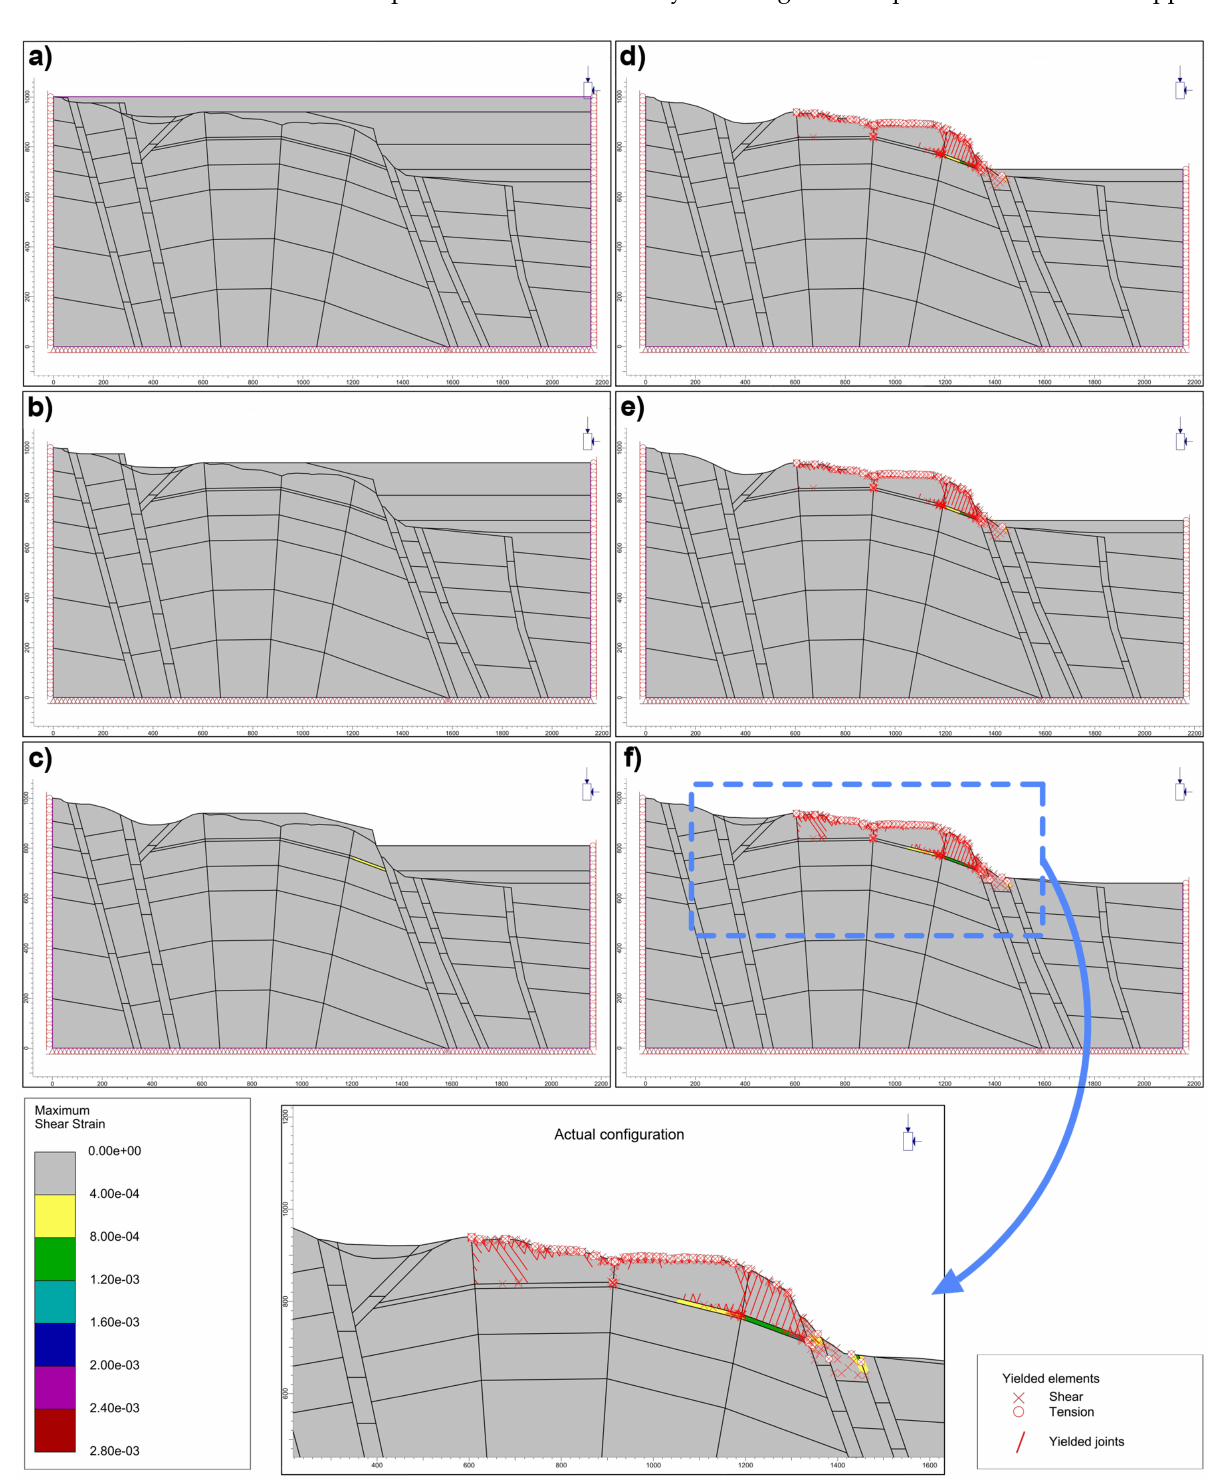
Figure 13. Evolutionary model, maximum shear strain, and yielded nodes/joints along the modeled section: ( a ) Initial condition; ( b ) Early-Middle Pleistocene; ( c ) Latest Middle Pleistocene; ( d ) Latest Pleistocene; ( e ) Latest Pleistocene after partial slope unloading; ( f ) Holocene. Visco-plastic deforma- tions were applied to stage ( e ) (90,000 years) and ( f ) (30,000 years). x -axis is in meters, while y -axis is in meters